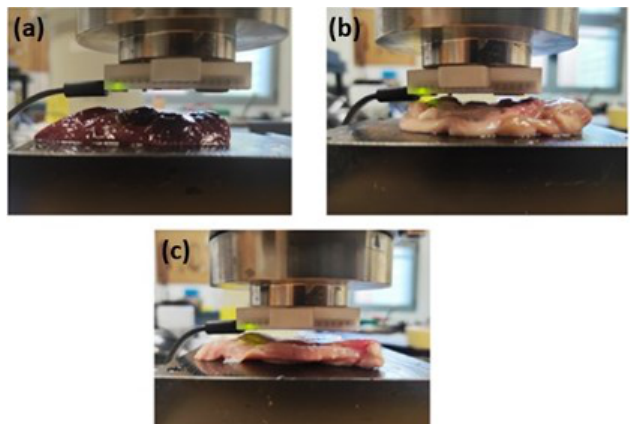
Figure 8. Tissue samples from the pig, placed on the plate below the sensor for the testing phase with the robot MELFA RV3-SB. ( a ) Liver. ( b ) Gut. ( c ) Stomach.